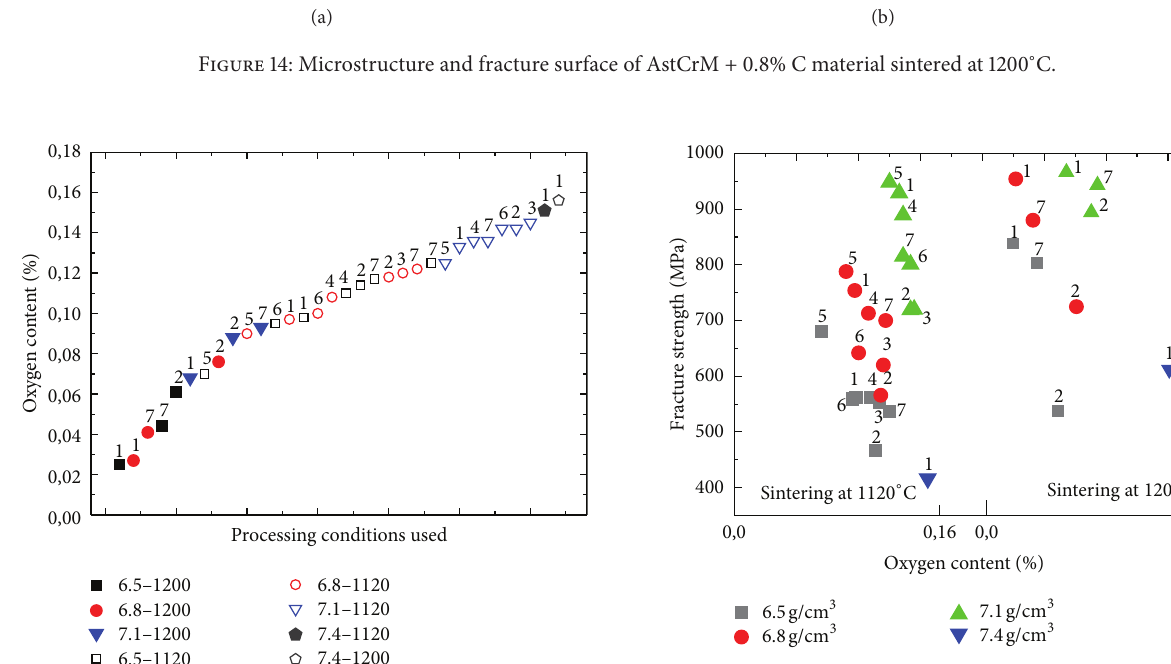
Figure 15: Oxygen content increasing in AstCrM-C alloys in relation to the processing conditions used.